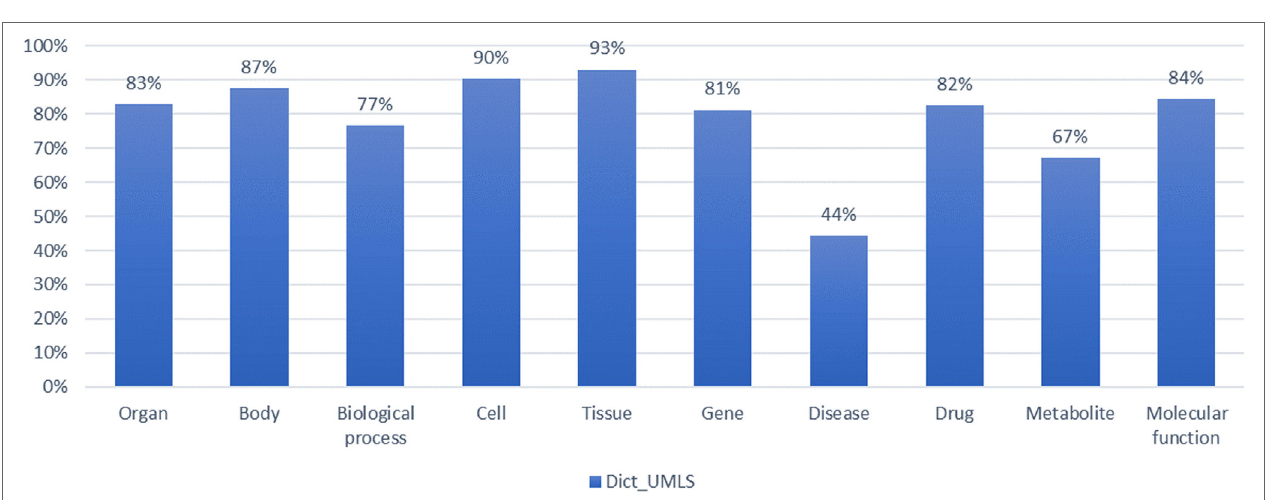
FigUre 8 | Evaluation of dictionary combined with Unified Medical Language System (UMLS) in the named entity recognition process by biomedical entity type.